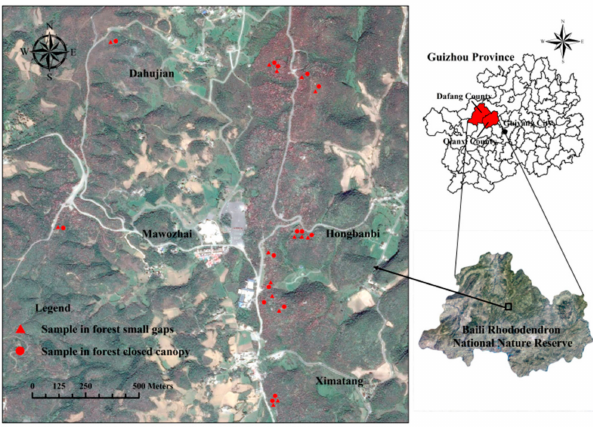
Figure 1. Spatial distribution of the sampling